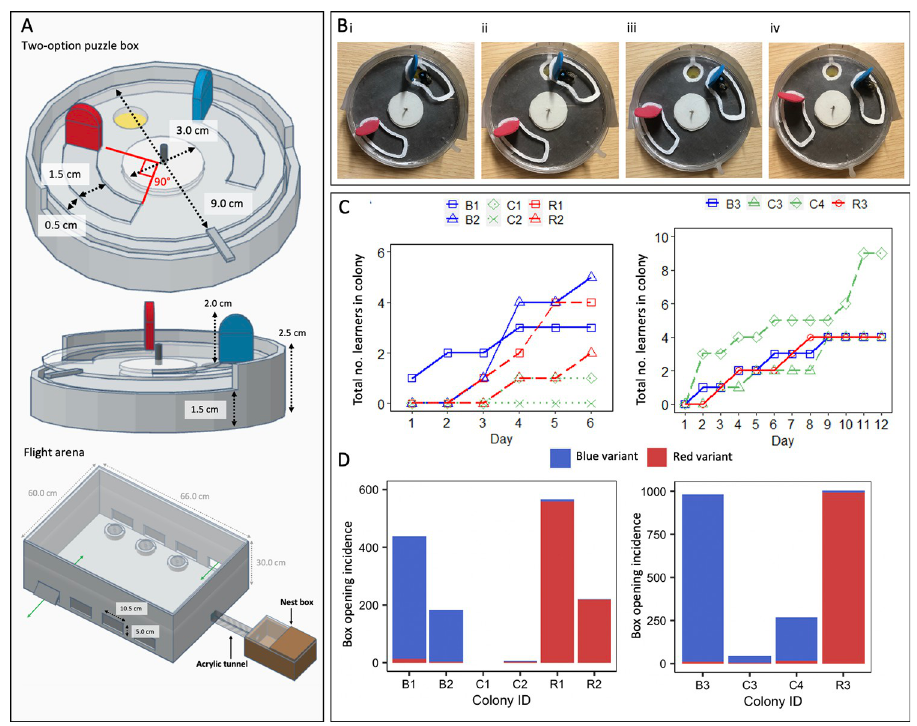
Fig 1. Box-opening behaviour spreads through bumblebee populations under open diffusion conditions. (A) Diagrams of puzzle boxes and the experimental flight arena used for the single-demonstrator diffusion experiments. Boxes were constructed from Petri dishes, with a base and lid serving as the static lower part of the box. This was covered with laminated grey, RGB neutral paper (hex #555555), which was lightly sanded to provide grip. An additional Petri dish lid with 2 cut-out tracks served as the rotating lid of the box. White acrylic “washers” and a nail formed the rotating mechanism. Red and blue tabs were cut from 2-mm thick polyethylene craft foam sheets and affixed to 1 end of the cut-out tracks as depicted; thus, when a bee landed in either track and pushed against its tab, walking forwards, it would rotate the lid of the puzzle box around the central axis and expose the reward (50% w/w sucrose solution on the yellow target). An external plastic “shield” encircled the box to prevent bees obtaining the reward by squeezing in at the sides, and a stopper prevented the lid from being over-rotated after the reward was exposed. The flight arena was connected to the nest box via an acrylic tunnel, and flaps cut in the side of the flight arena allowed the removal and replacement of puzzle boxes during the experiment. The sides were lined with bristles to prevent bees escaping. (B) Incremental demonstrator training protocol. Panels show the procedure to train a bee to perform the anticlockwise “blue-pushing behavioural variant,” to train a demonstrator to perform the clockwise “red-pushing behavioural variant,” the red tab would start over the reward instead. (i) Initial configuration with the box fully open and the yellow target completely exposed and accessible. (ii) In this configuration, the reward can still be obtained by reaching under the tab with the proboscis, but the tab is often pushed forward as the bee attempts this. (iii) The reward can no longer be obtained without moving the tab forwards. (iv) The 2 tabs are almost equidistant, with the blue tab approximately 1.0 cm closer to the yellow target than the red. Once a bee solved a box with this configuration twice in a single foraging bout, it progressed to the unrewarded learning test. (C) Diffusion curves for Experiment 1 (left panel) and Experiment 2 (right panel). Observers were considered to have learned after opening a box twice; they were only defined as having opened a box whenever they pushed either tab � 50% of the required distance, obtaining the reward. (D) Overall box-opening incidence by learners in Experiment 1 (left panel) and Experiment 2 (right panel). The incidence of each behavioural variant is indicated by colour. Colonies B1, B2, and B3 were each seeded with a blue-pushing demonstrator; colonies R1, R2, and R3 were each seeded with a red-pushing demonstrator; and colonies C1, C2, C3, and C4 were controls that lacked a demonstrator. Data for the whole colonies, including the demonstrator’s behaviour, can be found in S1 and S2 Figs and S1 Table. The data underlying this figure can be found in